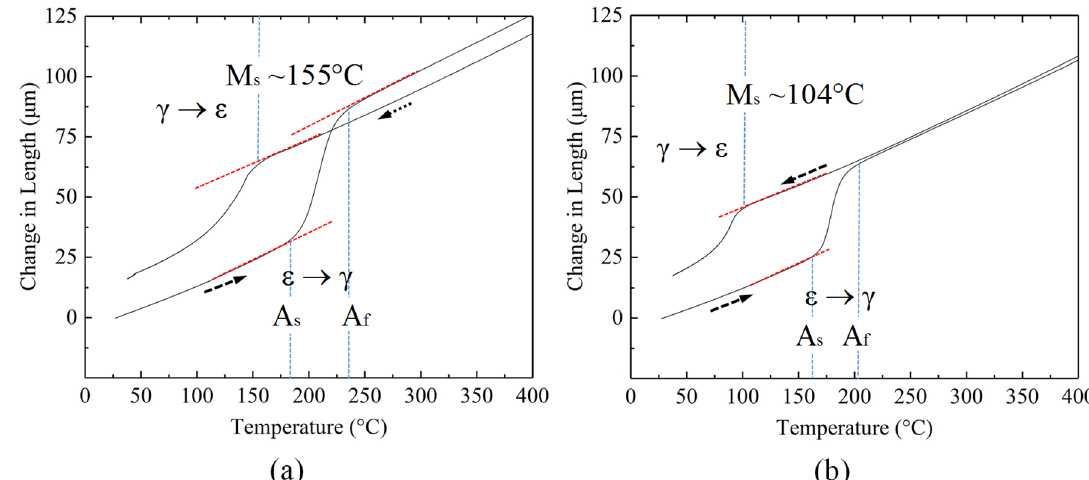
Figure 1. Dilatometric curves: (a) the Fe-19Mn alloy; (b) the Fe-19Mn-8Cr-1Co-0.2Si alloy.